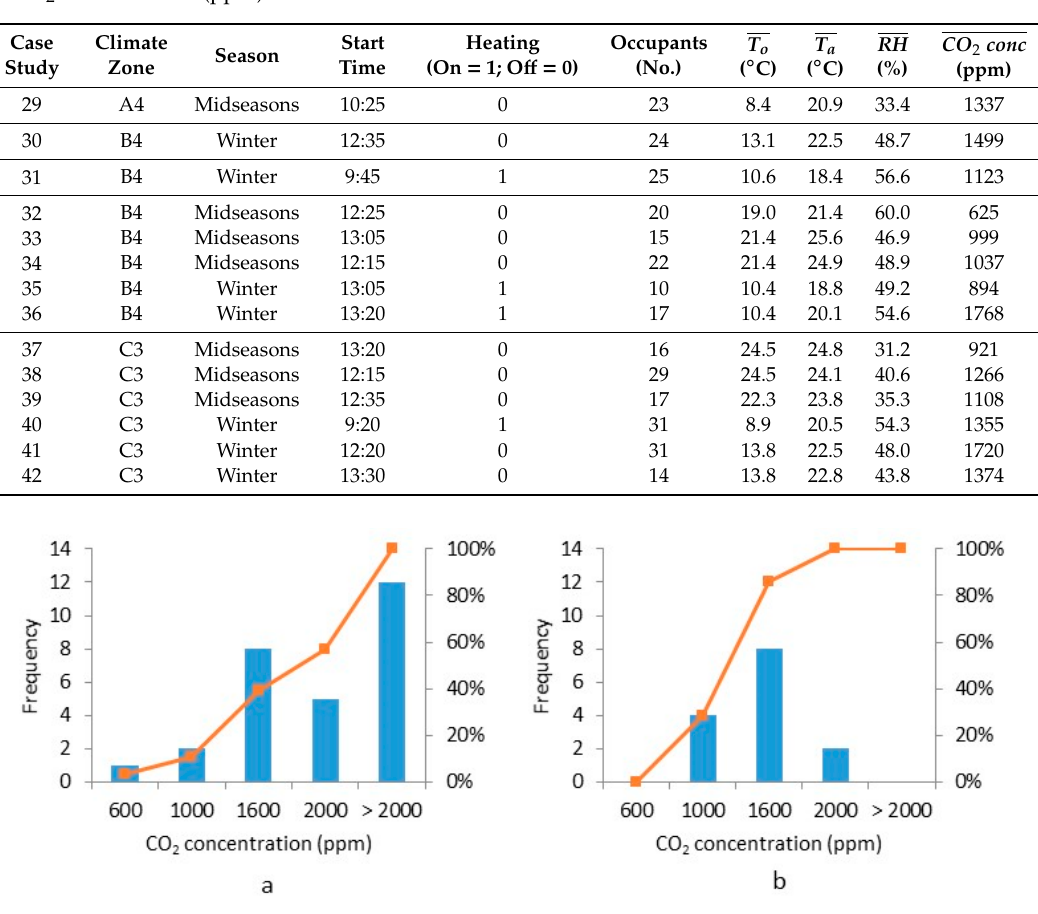
Figure 5. Accumulated frequency and percentage of measured CO 2 concentration in classrooms with closed windows ( a ) and open windows ( b ).